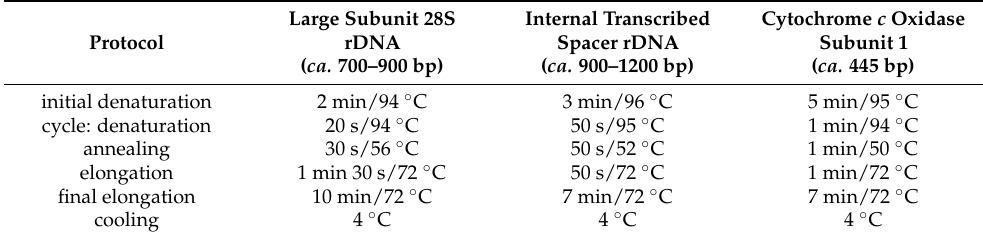
Table 1. Polymerase chain reaction protocols for the genetic markers of monogenean parasites; the expected amplicon size is mentioned for each marker. The number of cycles was 39 for the fragment of large subunit rDNA, and 40 for internal transcribed spacer rDNA and the partial cytochrome c oxidase subunit 1